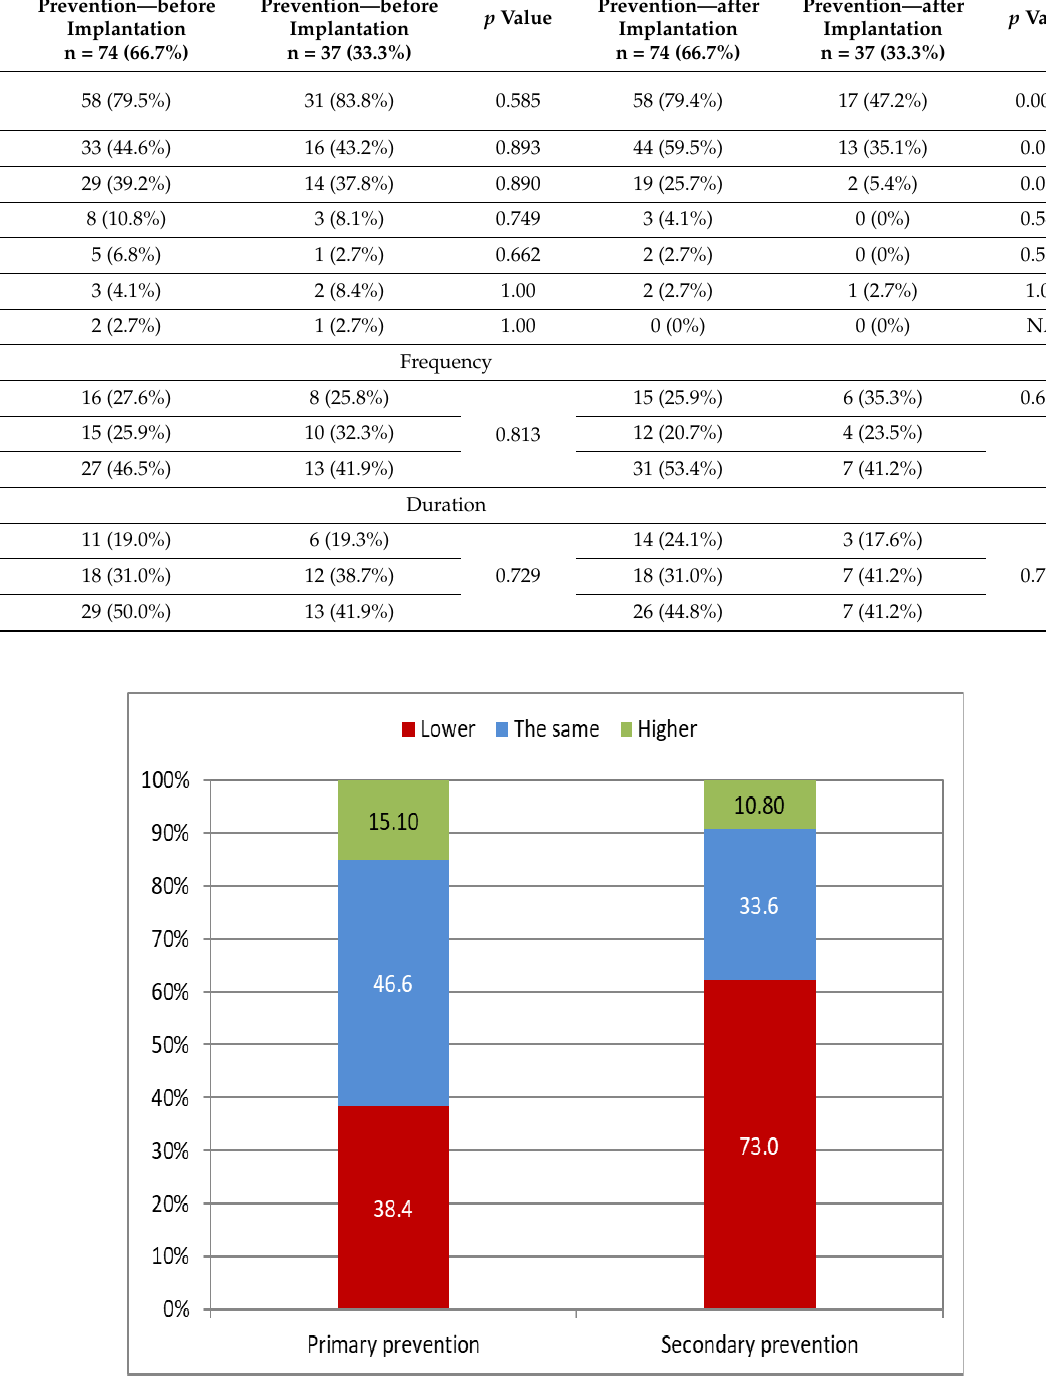
Figure 1. Change in physical activity after implantation, according to type of prevention. Although the median whole-week activity in the primary prevention group (4065 MET * minutes * number of days) is 25% higher than in the secondary prevention group (3252 MET * minutes * number of days), this difference is not statistically significant ( p = 0.717) (Table